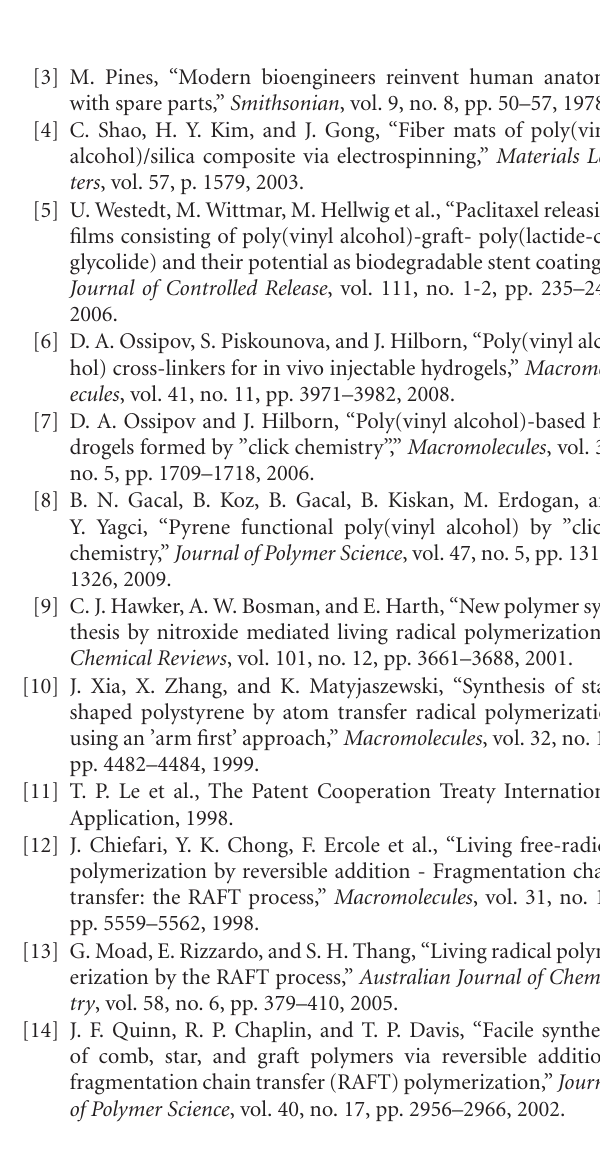
Figure 11: SEM surface image of the (a) unmodified poly(vinyl alcohol) and (b) modified poly(vinyl alcohol) with polystyrene through RAFT process.